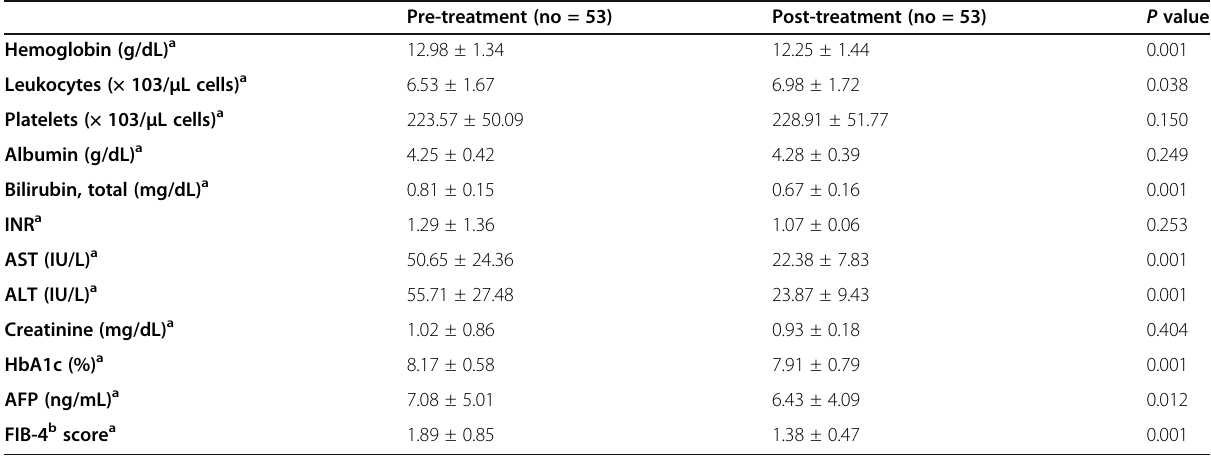
Table 4 Statistical comparison between pre-treatment and post-treatment parameters in glycemic non-improved patients Pre-treatment (no = 53)